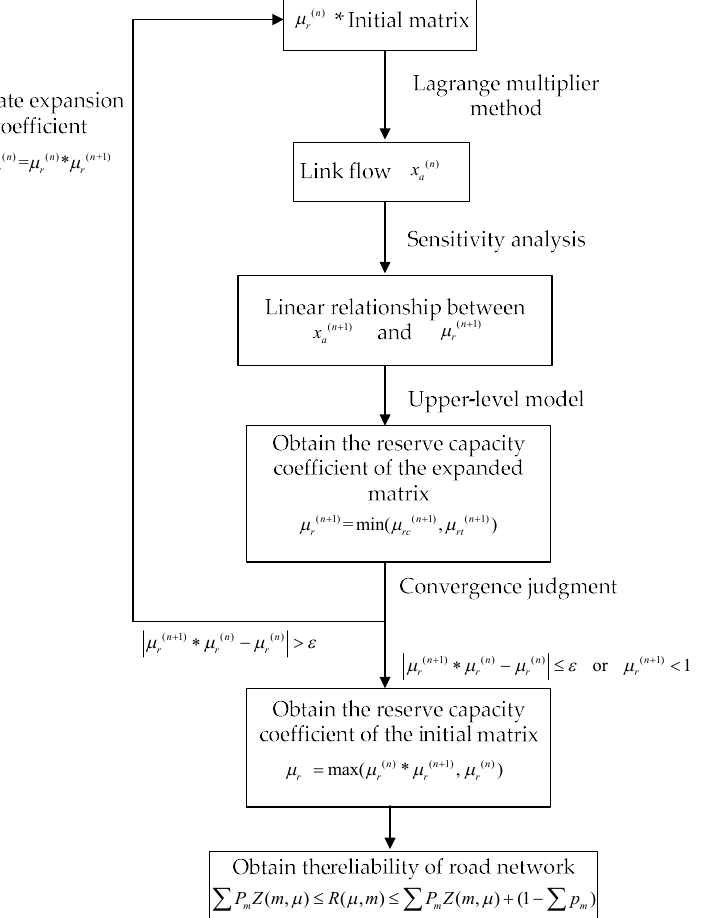
Figure 1. Flowchart of the algorithm.